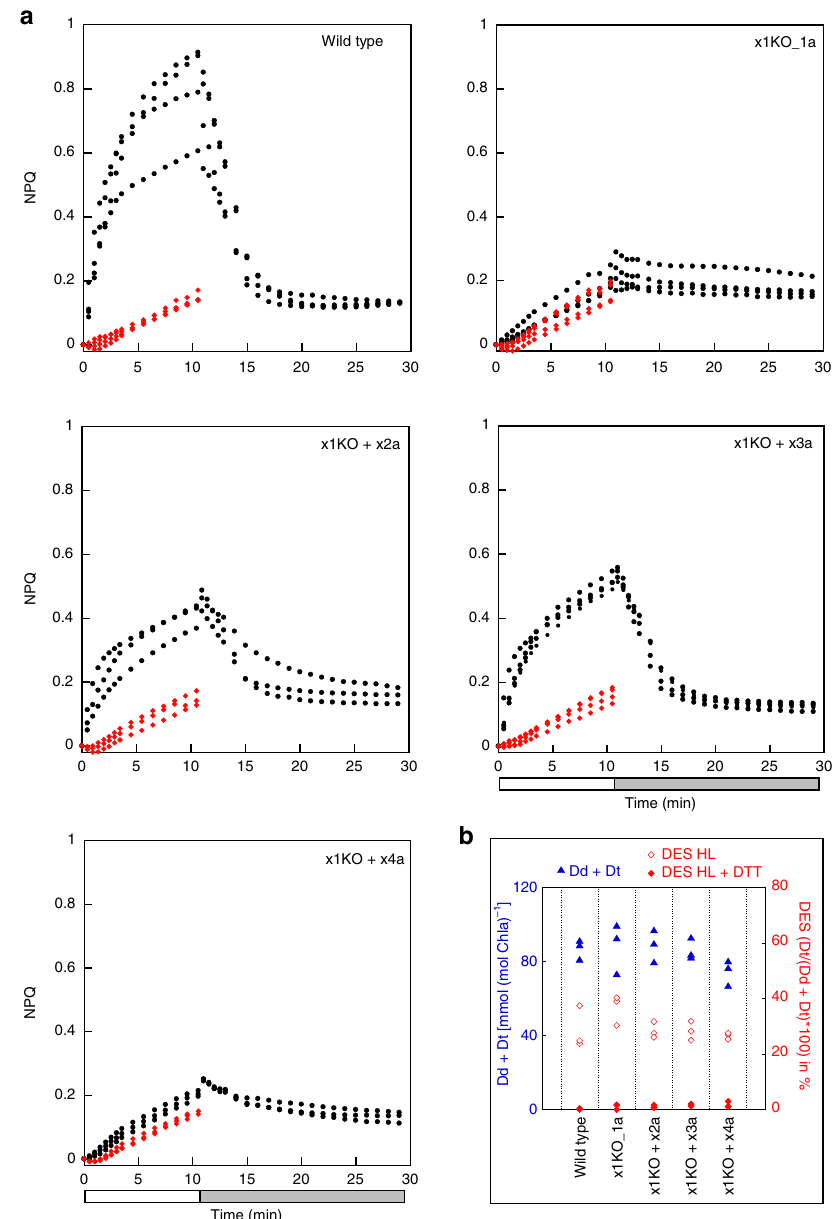
Fig. 3 NPQ kinetics and xanthophyll cycle activity in wild type and mutant strains. Strains were concentrated to a chlorophyll a amount of 10 mg L − 1 . a NPQ capacity of wild type (four biological replicates (BR)), x1KO_1a (four BR), and x1KO_1a supplemented lines x1KO + x2a (three BR), x1KO + x3a (four BR) and x1KO + x4a (three BR) during 10 min exposure to 1700 µ mol photons m − 2 s − 1 (white bar), followed by 18 min of low light (gray bar). Red points indicate samples that had been incubated with DTT prior to high light exposure in order to prevent diatoxanthin formation; b pool size of diadinoxanthin + diatoxanthin (Dd + Dt) per chlorophyll a and de-epoxidation state (DES) following 10 min illumination with 1700 µ mol photons m − 2 s − 1 without and with prior application of DTT. Three BR were measured. Source data are provided as a Source Data fi